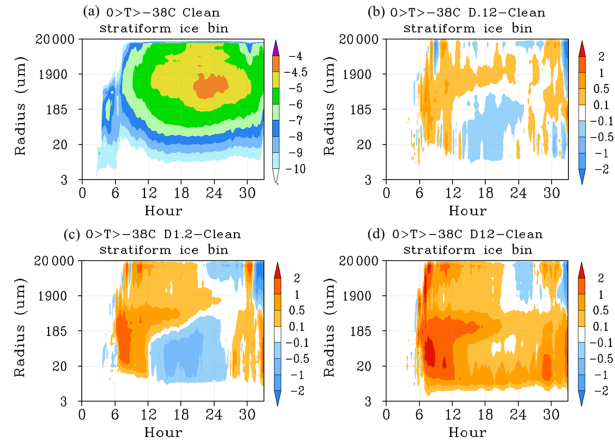
Figure 10. Time series and dust case minus Clean case differ- ence plots of ice or snow bin particle size distribution (PSD), av- eraged over the stratiform regime in the temperature range of − 5 to − 38 ◦ C. Contours represent log 10 values of bin